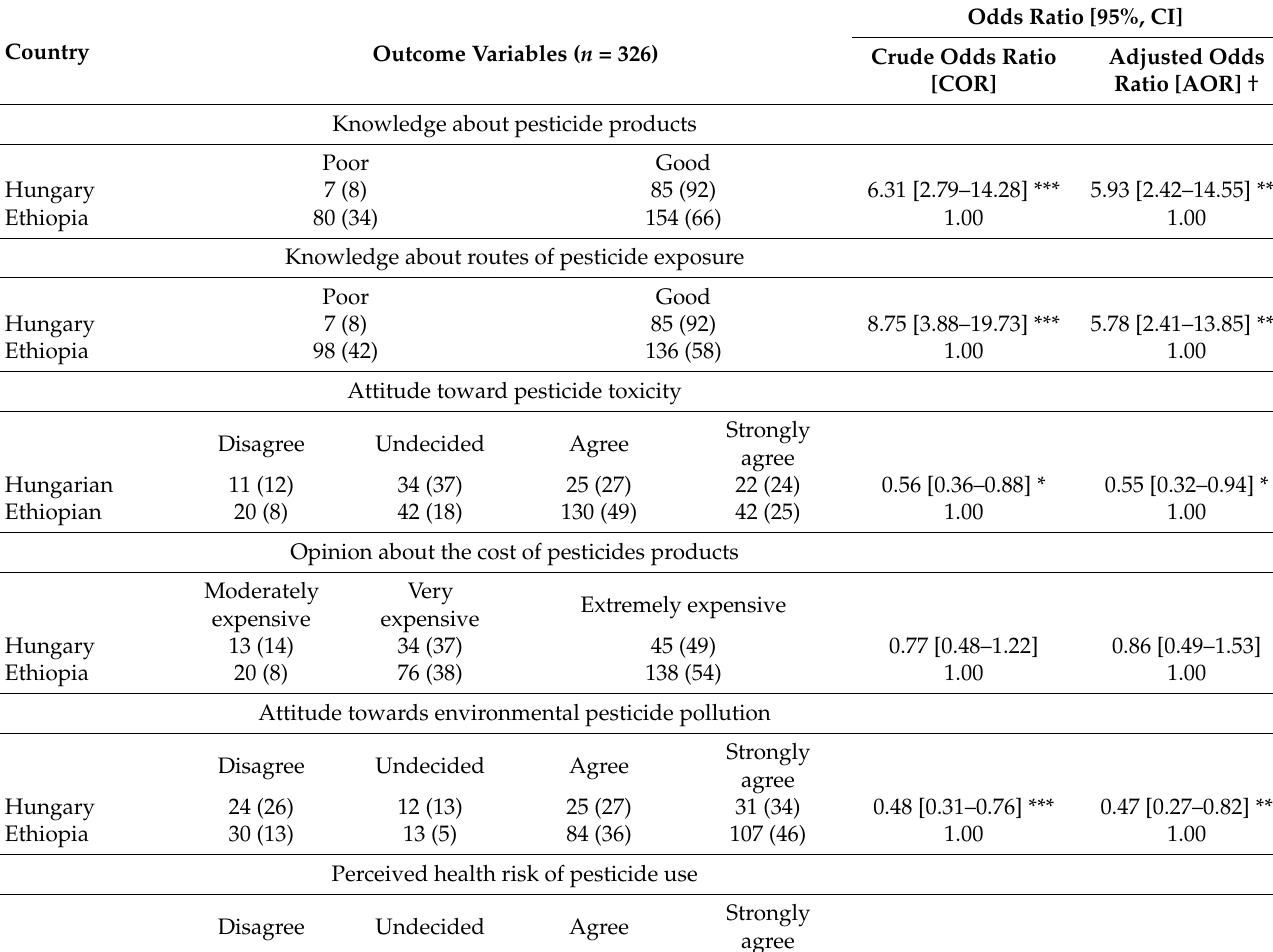
Odds Ratio [95%, CI] Crude Odds Ratio Adjusted Odds [COR] Ratio [AOR] †